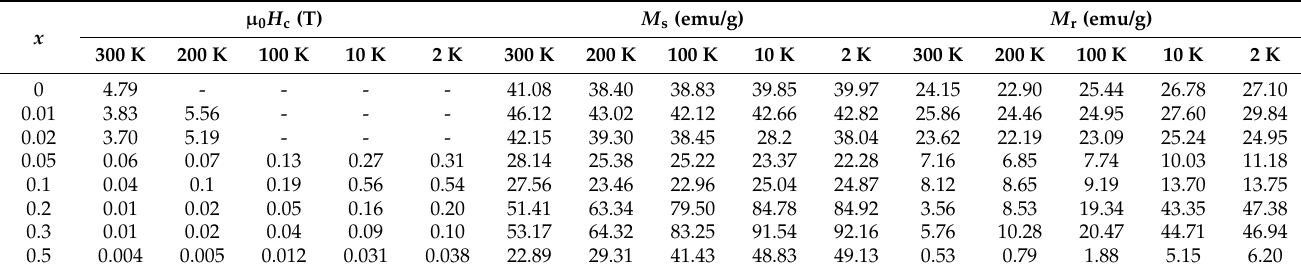
Table 2. Coercive field H c , magnetic saturation M s as well as magnetic remanence M r for all tested alloys determined from hysteresis loops measured at different temperatures. The errors of the listed values are in the level of the last printed